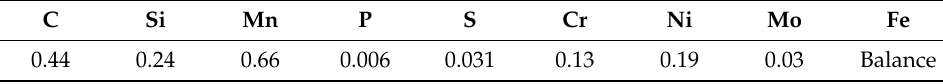
Table 1. Major alloy content (wt. %) of C45E steel used in the study.